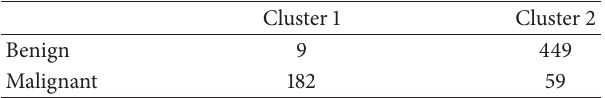
Table 9: Confusion matrix for the average clustering result with Hamming distance, for 𝑚 = 1.9